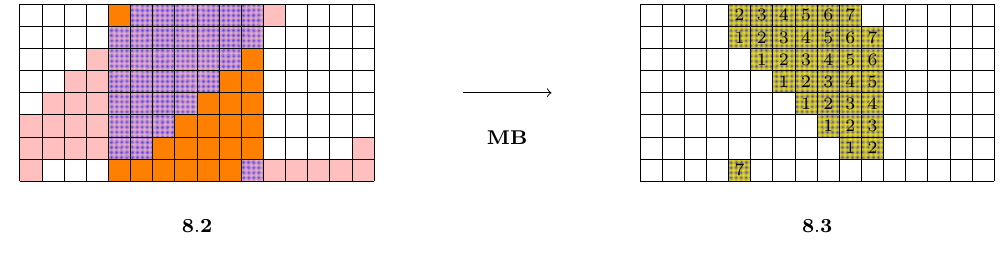
Figure 11: Merging lists, first